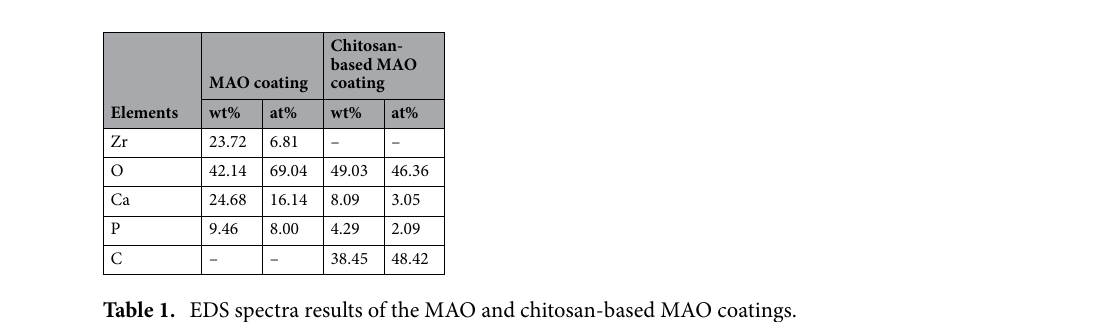
Figure 4. EDX-mapping analysis images of the coatings: ( a ) the MAO and ( b ) chitosan-based MAO surfaces.